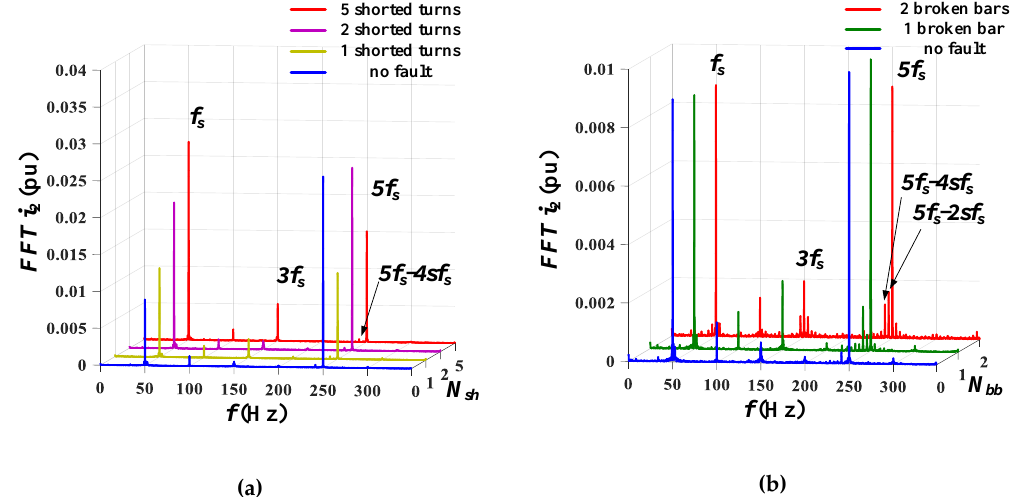
Figure 6. FFT analysis of the negative-sequence instantaneous symmetrical component i 2 of the stator current for nominal load torque and f s = 50 Hz with ( a ) different number of shorted turns N sh ; ( b ) different number of broken bars N bb .